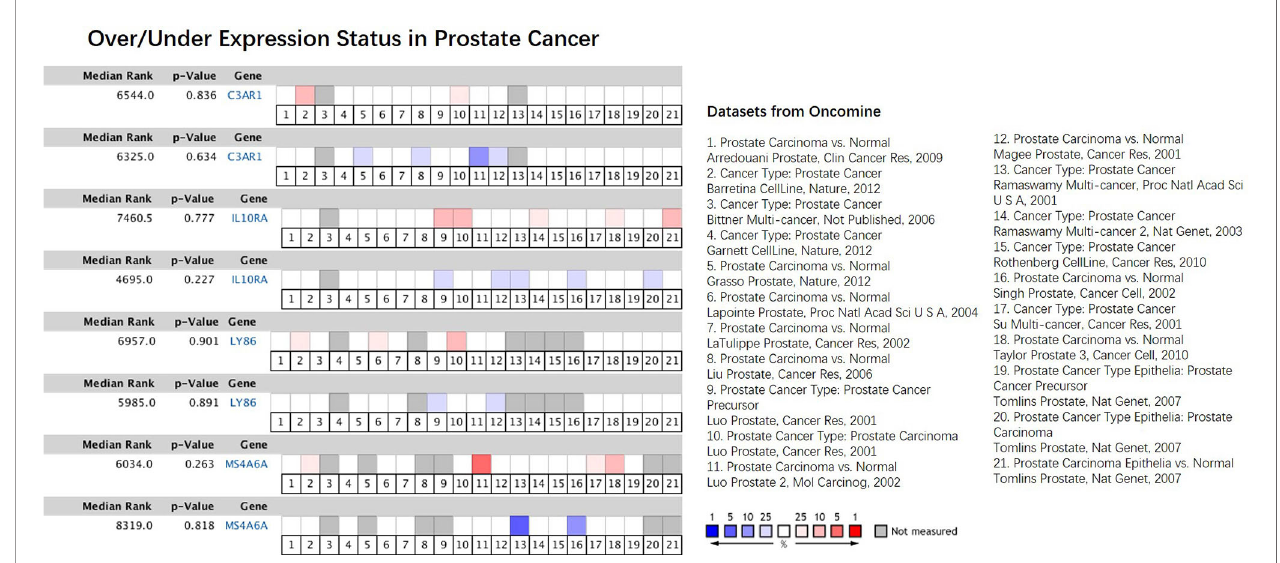
FIGURE 10 | Comparison of the four hub genes across 21 analyses of prostate cancer datasets. The colored box denotes the gene ’ s percentile rank for that analyses. The more saturated the color, the higher the percentile rank. Red denotes over-expression; blue denotes under-expression. The datasets were listed on the